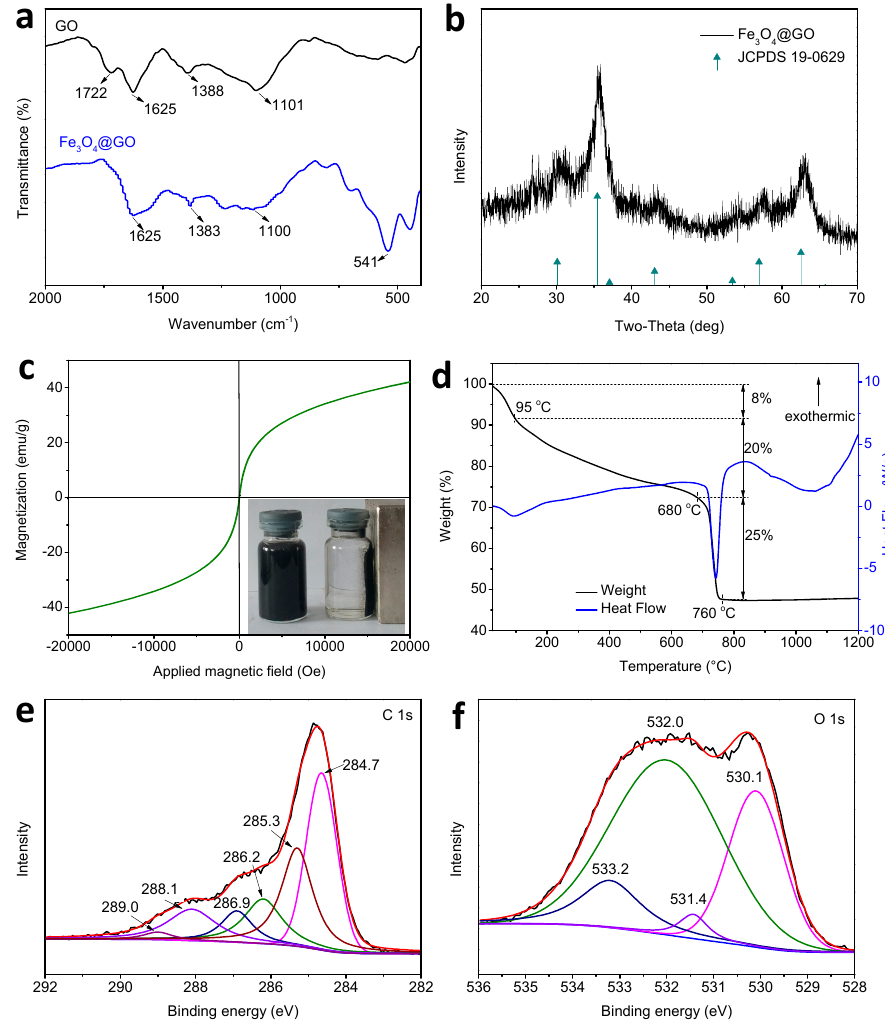
Figure 2. Characterization: ( a ) FTIR spectra of GO and Fe 3 O 4 @GO; ( b ) XRD pattern of Fe 3 O 4 @GO; ( c ) Magnetization curve (the right inset shows the magnetic separation of Fe 3 O 4 @GO); ( d ) TG-DSC curves; ( e ) C1s and ( f ) O1s XPS spectra of the Fe 3 O 4 @GO.